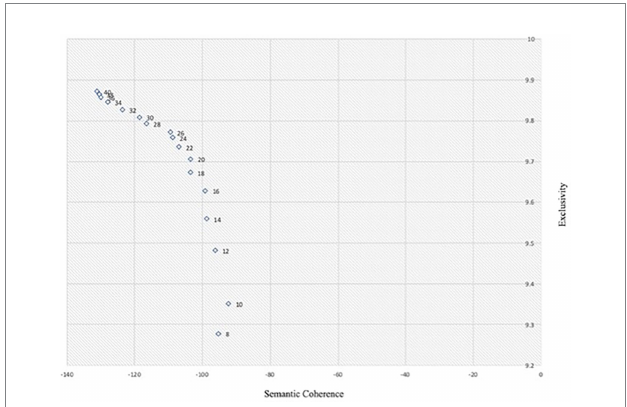
FIGURE 4 Semantic coherence and exclusivity of different topic model solutions. For the semantic consistency metric, the closer the value is to 0, the better. For the exclusivity metric, the closer the score is to 10, the